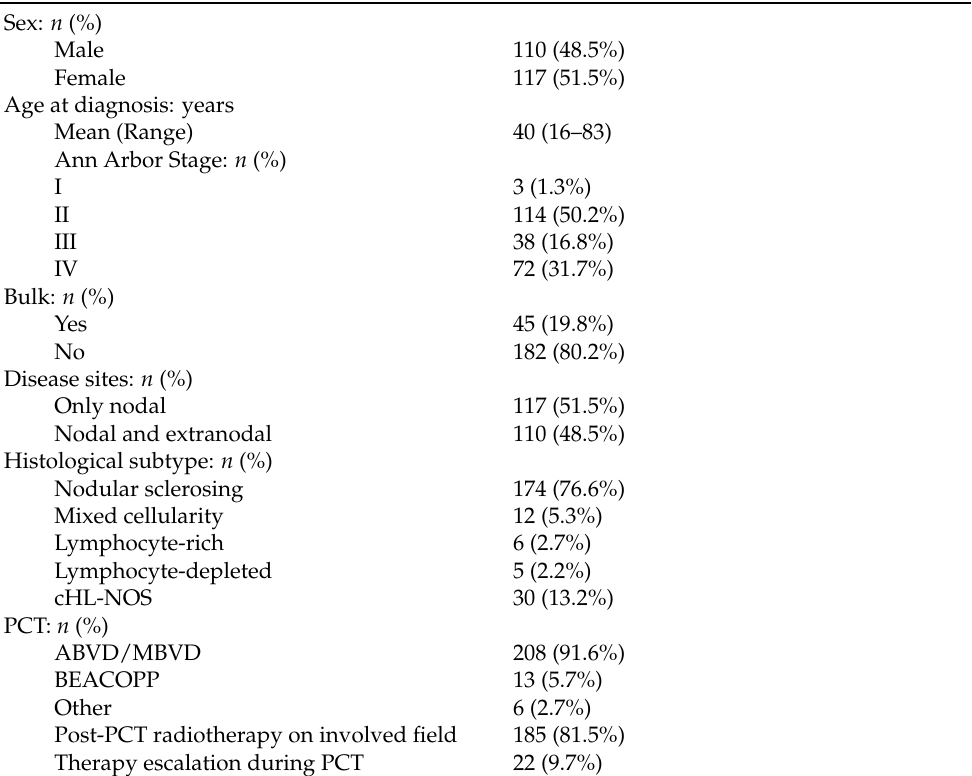
Table 2. Patients’ characteristics ( n =